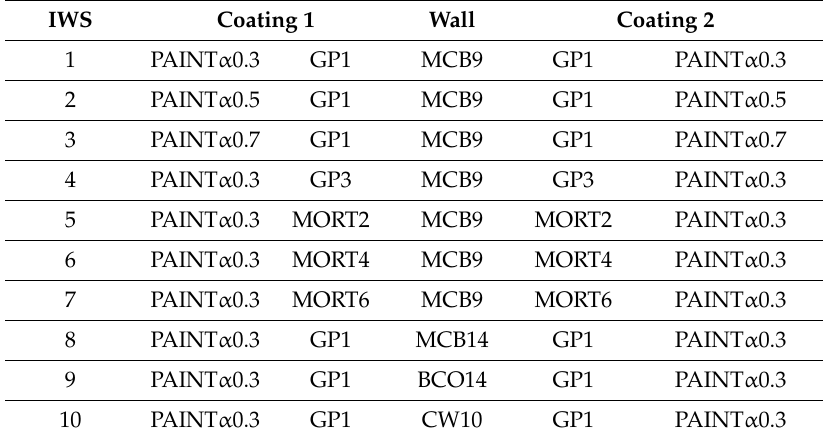
Table 10. Internal wall systems (IWS) considered in numerical